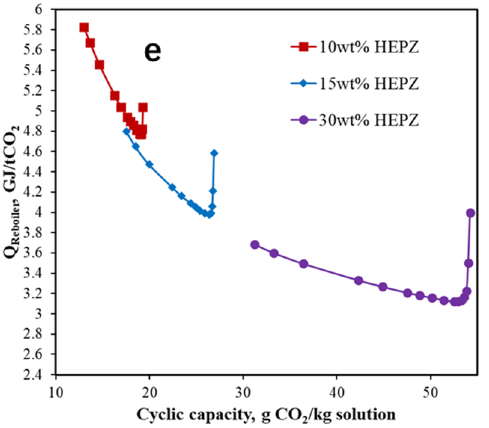
Figure 4. The relationship between reboiler energy consumption, Q reb , and circulating absorption: ( a ) MEA, ( b ) DMEA, ( c ) 1-MPZ, ( d ) AMP and ( e ) HEPZ.